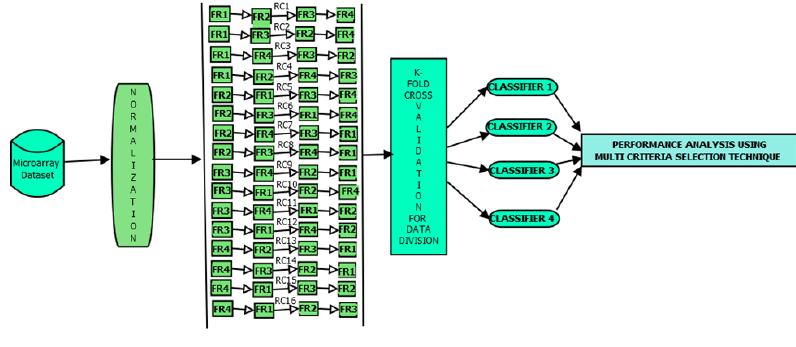
Figure 2. Detailed Flow Diagram of the Proposed